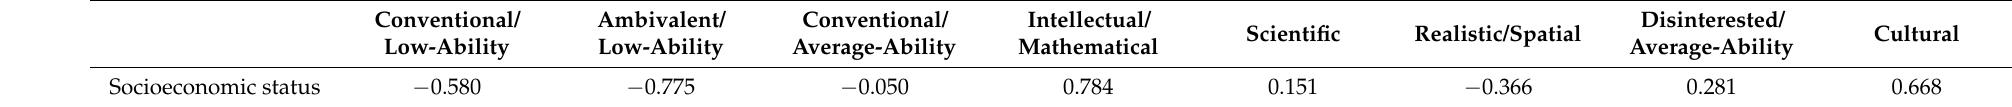
Table 4. Equality test of socioeconomic status means across the eight profiles.